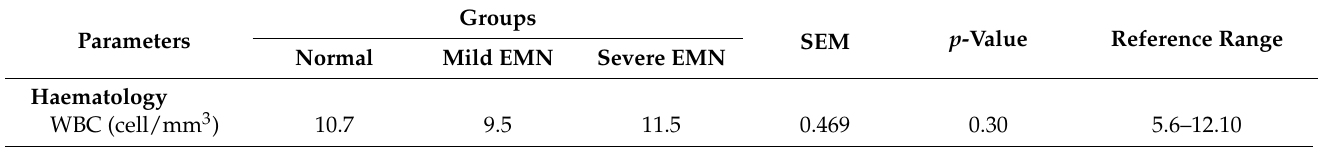
Table 2. The haematology and serum blood chemistry profiles of horses with different EMN stages. Groups Parameters SEM p -Value Reference Range Normal Mild